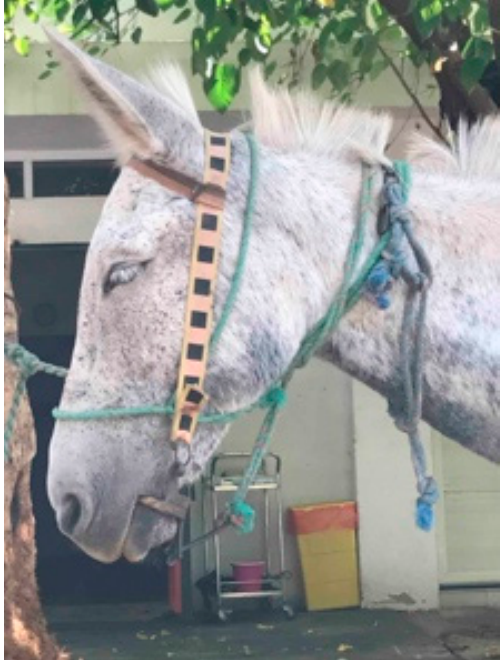
Figure 2. Mules and hinnies are often worked or ridden with harsh equipment to control their behavior such as this ring bit. This can result in lacerated tongues and/or paralysis to the tongue. Improved understanding about learning theory could help reduce the use of such abusive equipment.